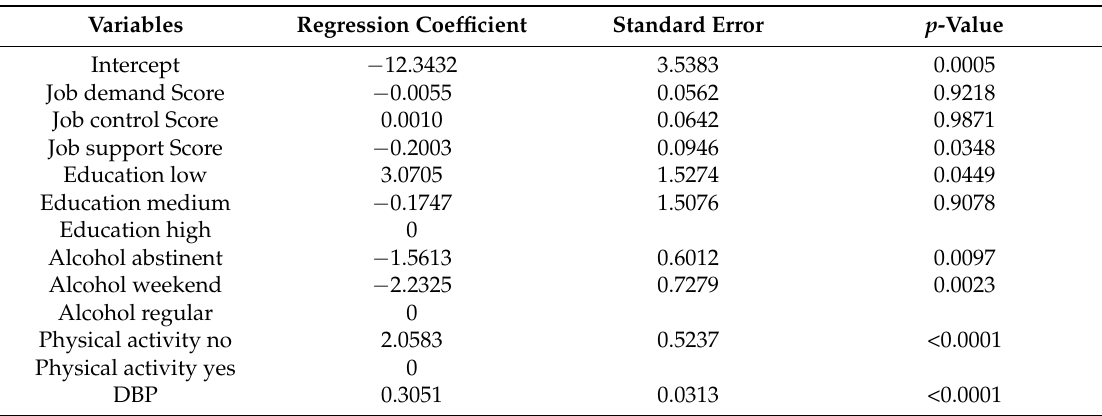
Table 6. Multiple linear regression predicting CVD risk score (R 2 = 0.2713; adjusted R 2 = 0.2595). Independent variables: educational level, alcohol intake, DBP, job demand score (continuous), job control score (continuous), job support score (continuous), and physical activity.